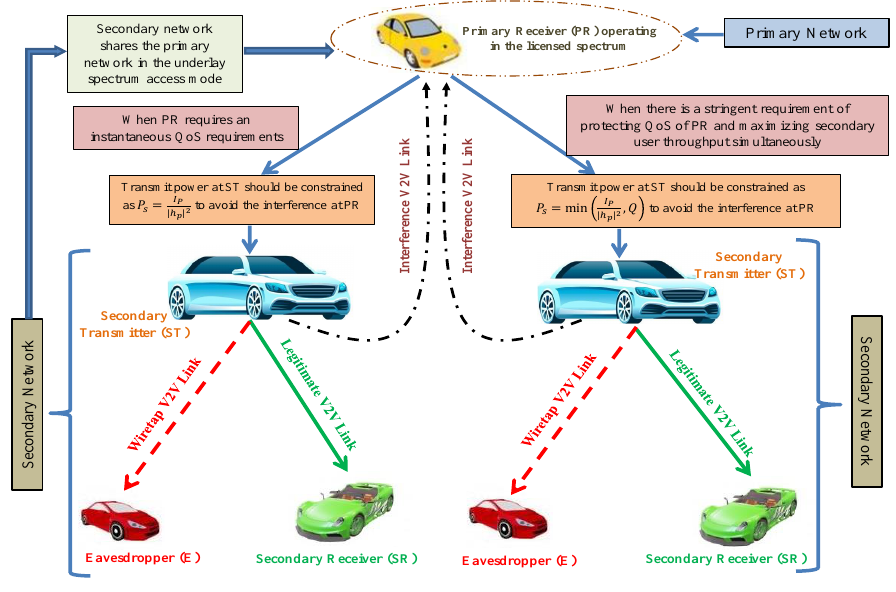
Figure 2. Overall representation of the considered CRVN